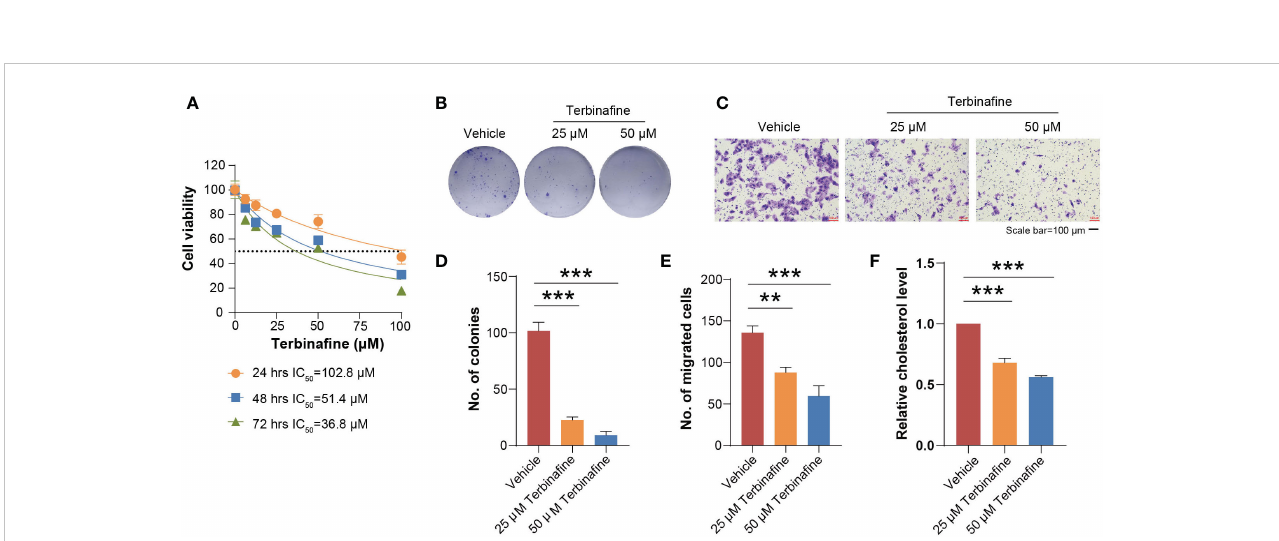
FIGURE 6 Terbina fi ne treatment impaired the growth and migration of U2OS cells in vitro . (A) Different gradient concentrations of terbina fi ne were added to the U2OS cells. As the dosage of terbina fi ne increased, the viability of the cells decreased. (B) The U2OS cells were respectively treated with 25 m M and 50 m M terbina fi ne. Cell colony formation ability was found reduced with the increasing dosage of terbina fi ne. (C) The number of migrating cells decreased obviously with the increase in drug concentration. Scale bars, 100 m m. (D, E) indicated the quanti fi cation of positive signals from (B, C) , respectively. (F) The terbina fi ne treatment signi fi cantly reduced the intracellular cholesterol. Error bars represent mean ± SD; statistical analysis was performed using the Student t-test. **P < 0.01, ***P < 0.001.